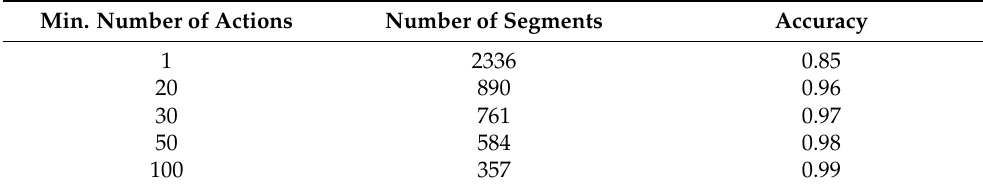
Table 8. Test on the number of actions